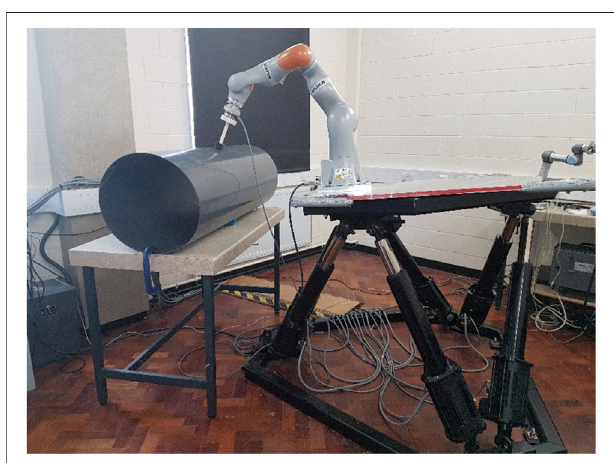
FIGURE 7 | Emulating UVMS via using a KUKA IIWA manipulator mounted on a Stewart Platform and interacting with a pipe.